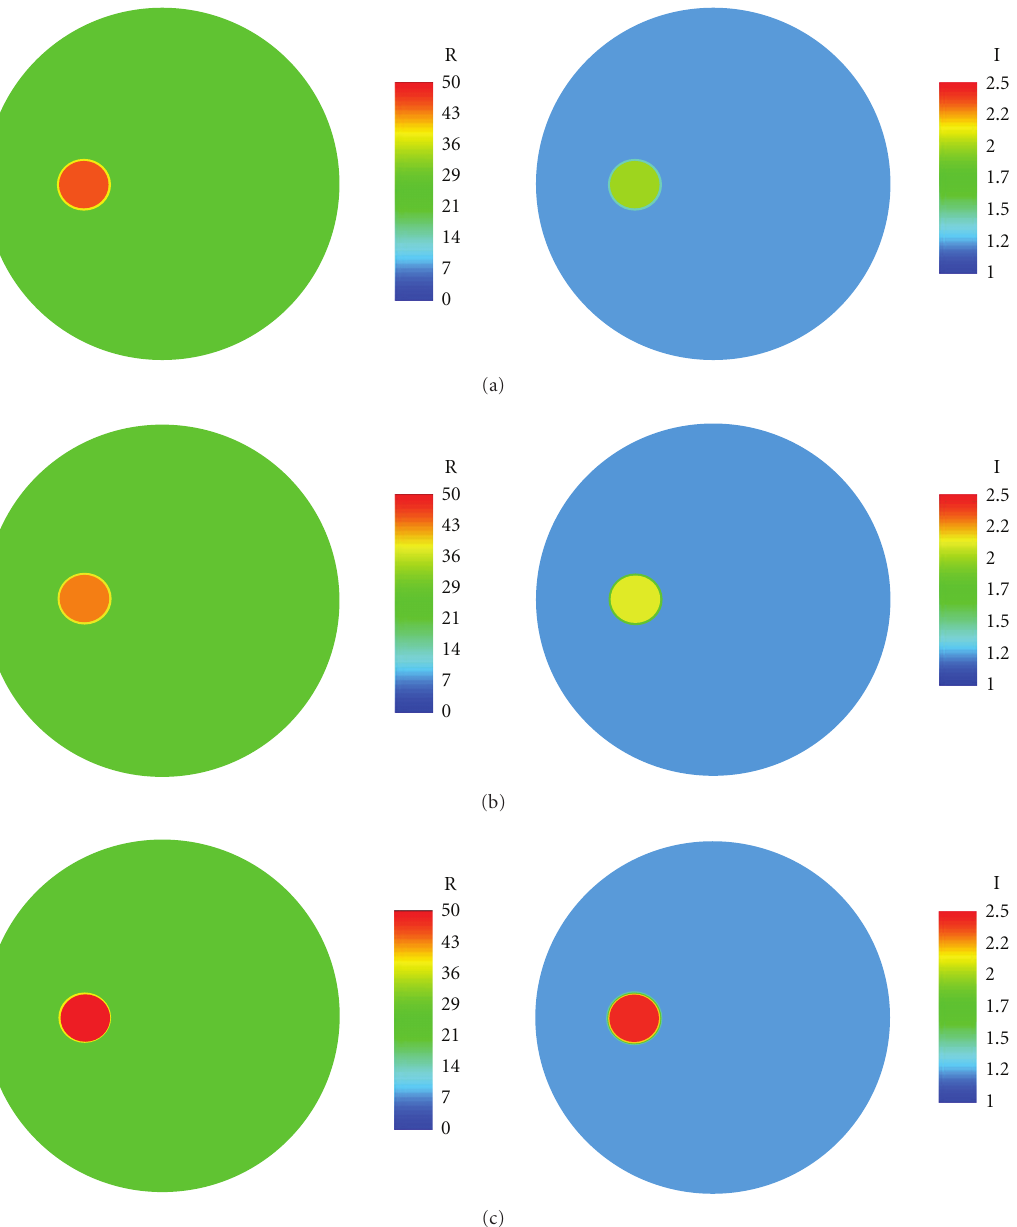
Figure 7: Reconstructed permittivity images (left) of the (a) 1st, (b) 2nd, and (c) 5th microwave scan of a saline-saturated bone specimen in a test tube at 1100 MHz, respectively. The green background shows the permittivity of the coupling liquid (80% glycerin) inside the imaging tank. The images on the right are the corresponding conductivity